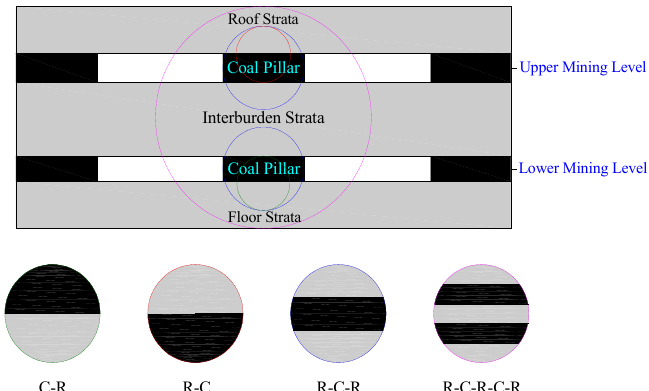
Figure 1. Different kinds of sandwiched coal-rock systems involved in ultra-close multiple seam mining.(C-R—Coal pillar and floor strata system; R-C—Roof strata and coal pillar system; R-C-R—Roof strata, coal pillar, and floor strata system; R-C-R-C-R—Roof strata, upper coal pillar, interburden, lower coal pillar, and floor strata system)